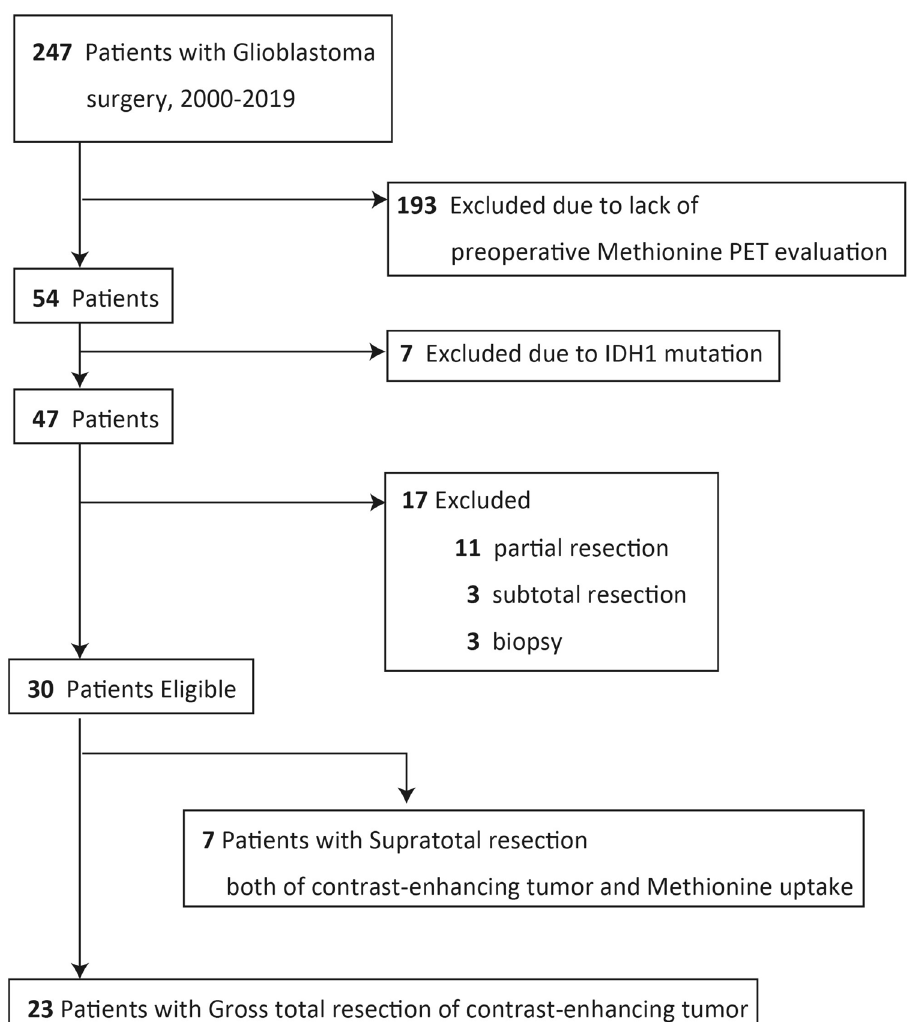
Figure 1. Data flow diagram for patient inclusion. Met-PET, 11 C-methionine positron emission tomography; IDH1 , isocitrate dehydrogenase